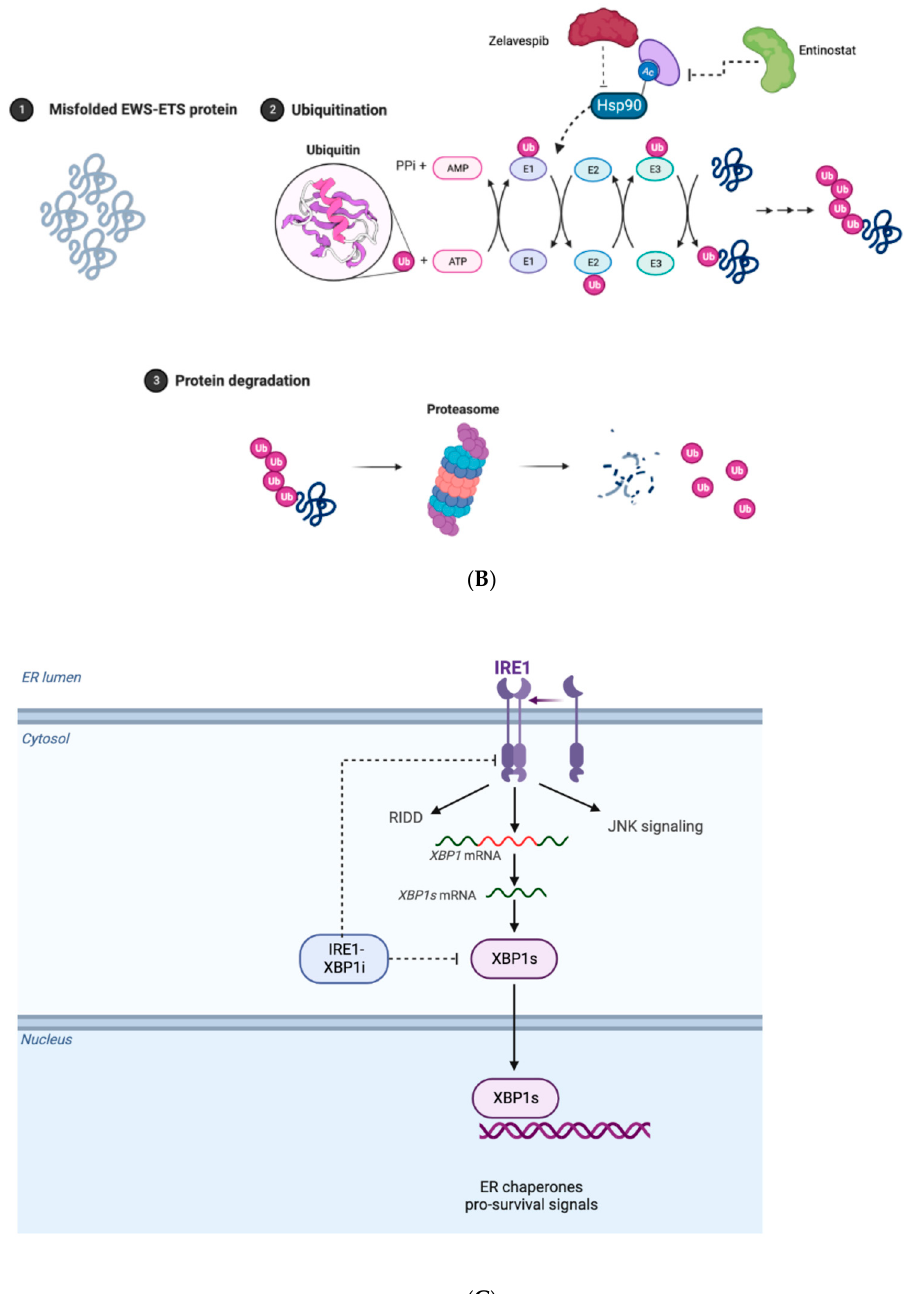
Figure 3. ( A ) Mechanisms of activation and inhibition of AURKs and its downstream effects. ( B ) Misfolded and accumulated EWSR1-ETS protein are ubiquitinated with the help of chaperones protein and directed to proteasome system in order to be degraded and guarantee homeostasis in proliferating cells; when Zelavespib, a HSP90i, and Entinostat, a HDACi, inhibit the ubiquitination of misfolded and accumulated proteins via proteasome, cells died due to proteotoxic stress. ( C ) ER stress induces oligomerization / tetramerization of IRE1 in ER leading to the unconventional splicing of XPB1 in XPB1s that enhances pro-survival signals; IRE1 α -XBP1 inhibitors inhibit this process suppressing viability of cancerous cells. (Created with BioRender.com).